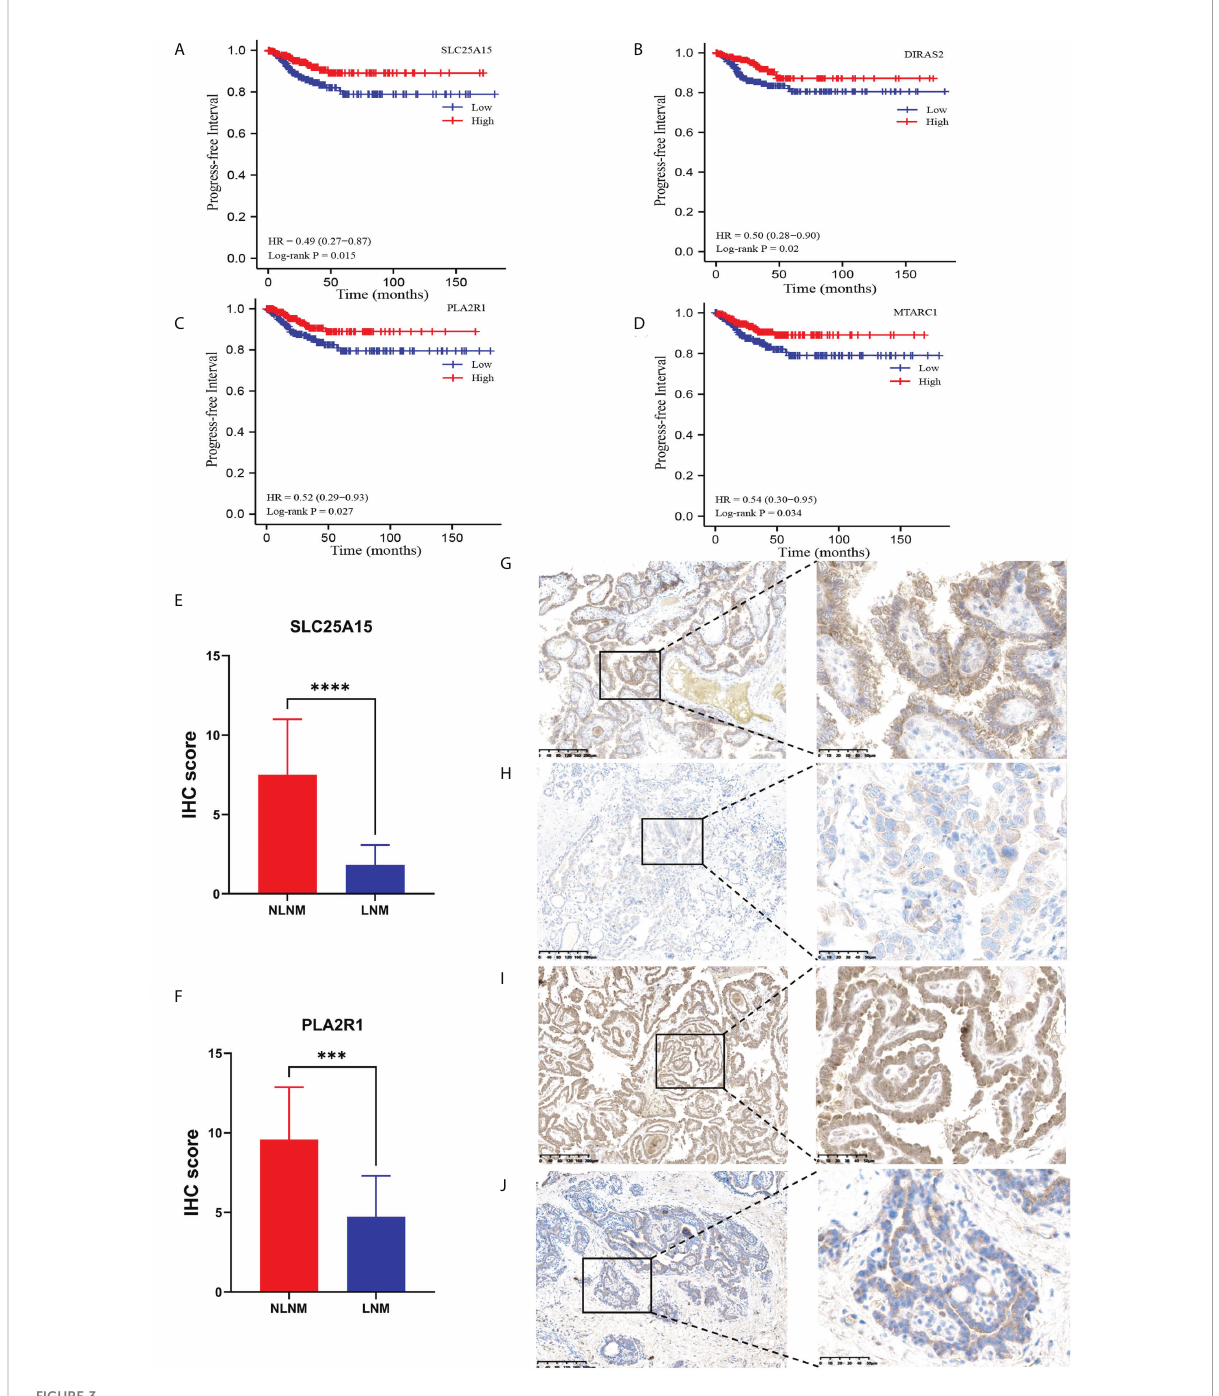
FIGURE 3 Kaplan – Meier survival curves (log-rank test) showing the correlation between progression-free survival and DEP expression (SLC25A15, DIRAS2, PLA2R1, and MTARC1). (A) SLC25A15 mRNA expression in thyroid tumorous tissues is positively related to poor prognosis (log-rank test P = 0.015); (B) DIRAS2 mRNA expression in thyroid tumorous tissues is positively associated with poor prognosis (log-rank test P = 0.020); (C) PLA2R1 mRNA expression in thyroid tumorous tissues is positively associated with poor prognosis (log-rank test P = 0.027); (D) MTARC1 mRNA expression in thyroid tumorous tissues is positively associated with poor prognosis (log-rank test P = 0.034); (E, F) Validation of the differential expression of SLC25A15 and PLA2R1 between LNM and NLNM in another independent cohort. IHC staining was assessed as the sum of the percentage and intensity scores. (***) P <0.001, (****) P <0.0001. (G – J) Representative IHC staining of SLC25A15 (G , NLNM; H , LNM ) and PLA2R1 (I , NLNM; J , LNM ) in tumorous